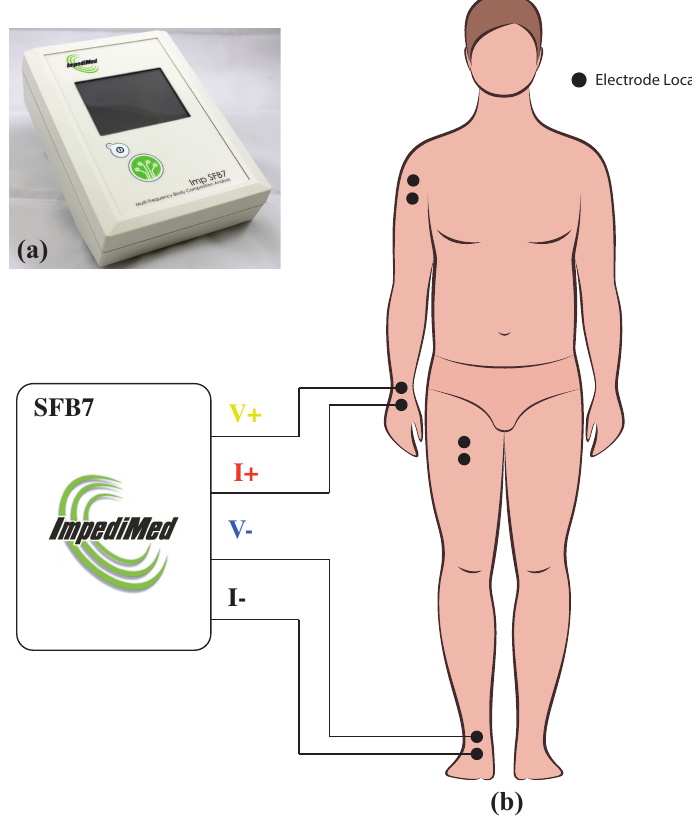
Figure 2. ( a ) ImpediMed SFB7 device to collect participant electrical impedance using ( b ) referenced electrode locations to measure segmental right arm, segmental right leg, and right full-body of each study participant with tetrapolar